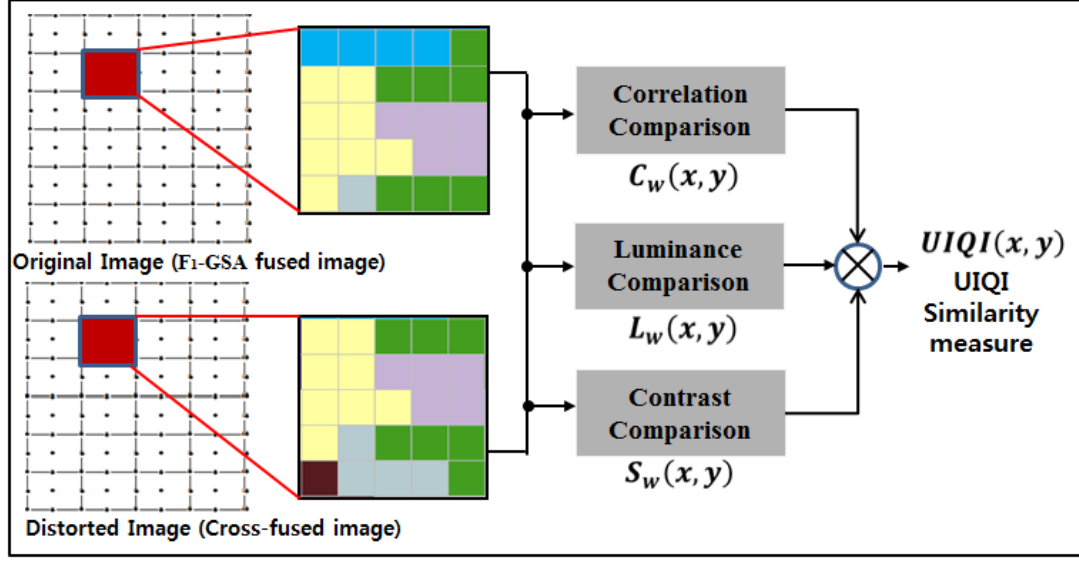
Figure 3. Illustration of the universal image quality index (UIQI) measurement